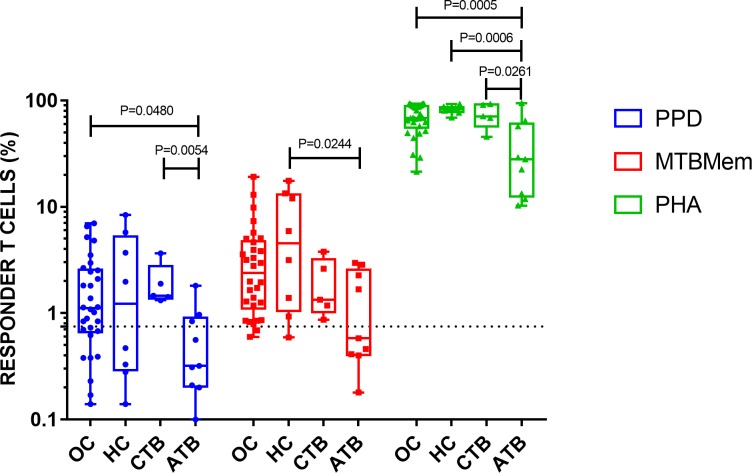
Proliferative T cell responses to MTB antigens and mitogen (key) declined with escalating exposure to the infection.Box and whisker plots show individual responses of occupational contacts (OC), household contacts (HC), cured TB (CTB) and active TB (ATB) patients. Cutoff for a positive response (0.75% responder cells) is depicted by dashed line. P values for significant differences are shown on the top of corresponding columns.